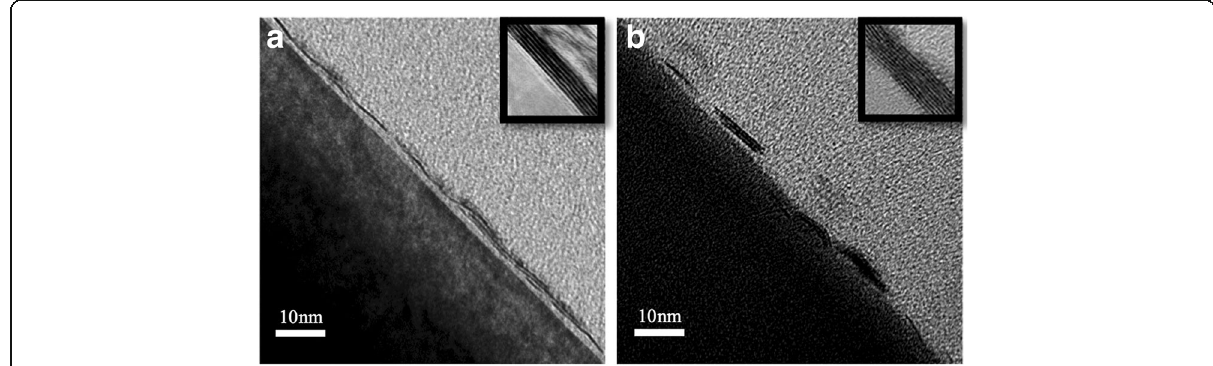
Fig. 4 High-resolution transmission electron microscopy cross section images of WS 2 ( d WO3 = 1 nm) grown on a Al 2 O 3 and b SiO 2 substrates. Insets show corresponding image for the thick WS 2 ( d WO3 = 8